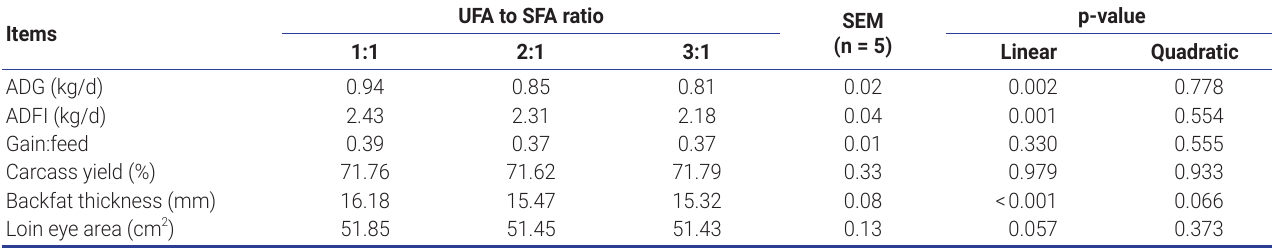
Table 3. Effects of dietary unsaturated to saturated fatty acids ratios on growth performance of finishing pigs Items